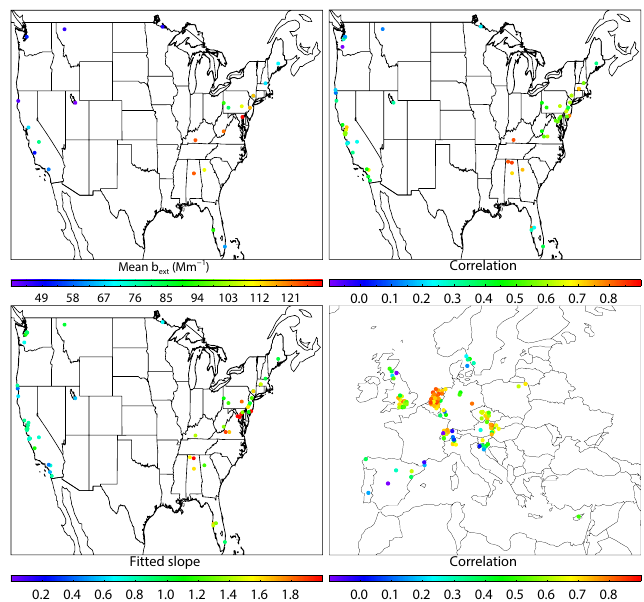
Figure 3. Spatial distribution of (top left) average of the collocated b ext of IMPROVE stations, (top right) Pearson correlation coefficients between collocated pairs of monthly ISD 1/Vis and IMPROVE b ext , (bottom left) slope of monthly b ext against monthly 1/Vis after linear fitting through the origin point using the reduced major-axis linear regression (Ayers, 2001) and (bottom right) Pearson correlation coefficients between collocated pairs of monthly ISD 1/Vis and EMEP PM 2 . 5 .